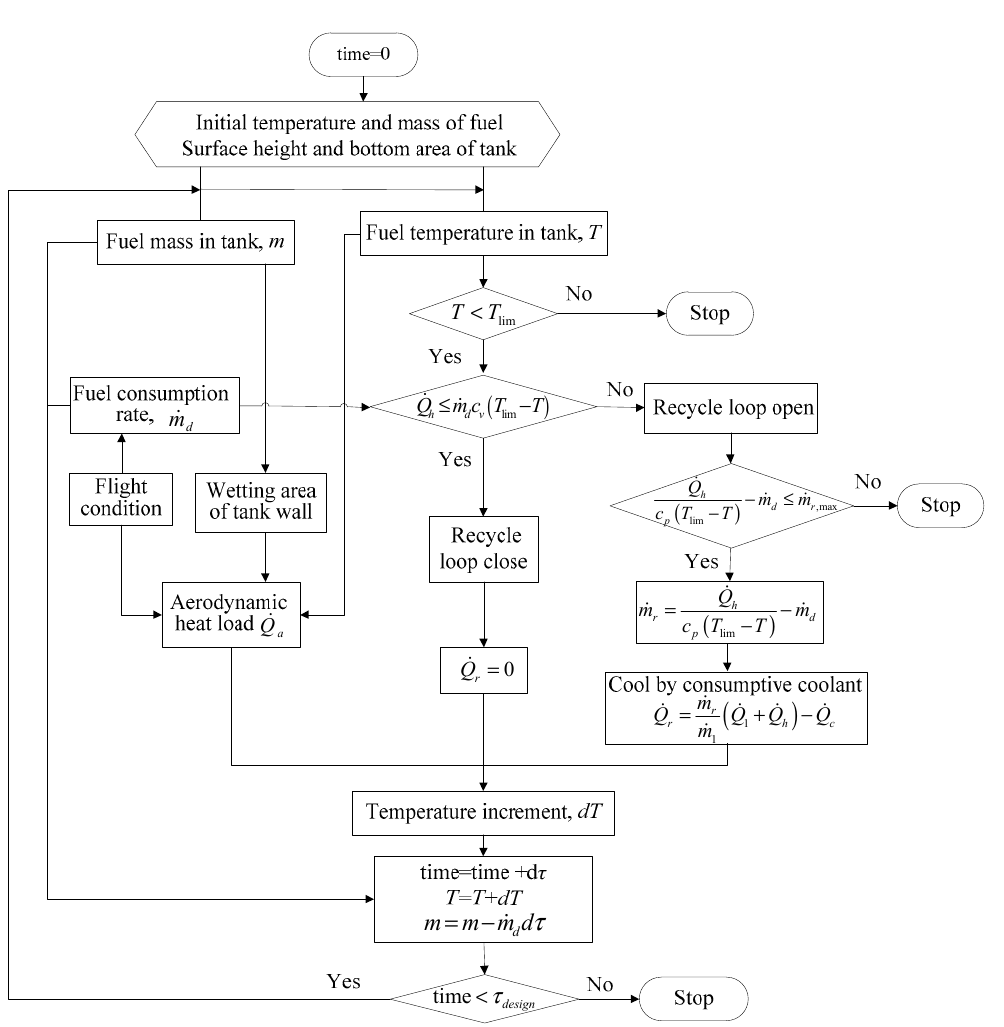
Figure 2. Flow chart to solve characteristic equations.